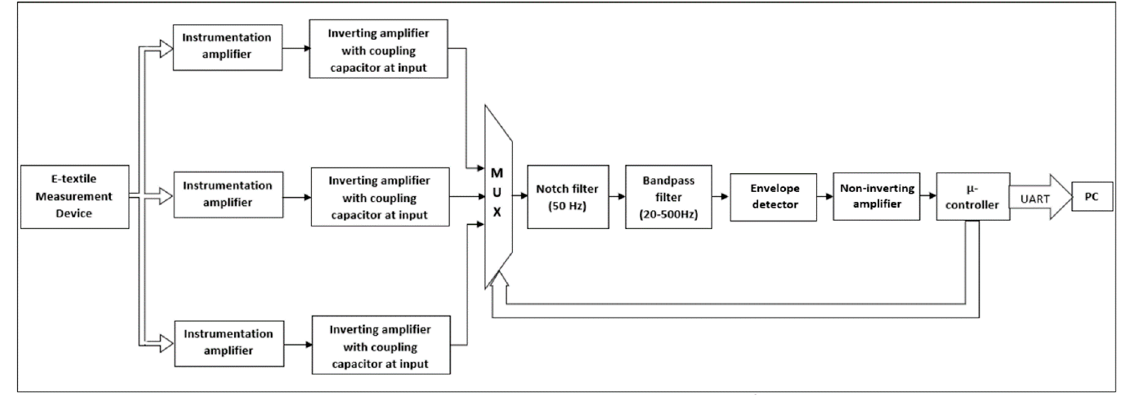
Figure 1. Final full system block diagram for the e-textile gesture controller via EMG monitoring.